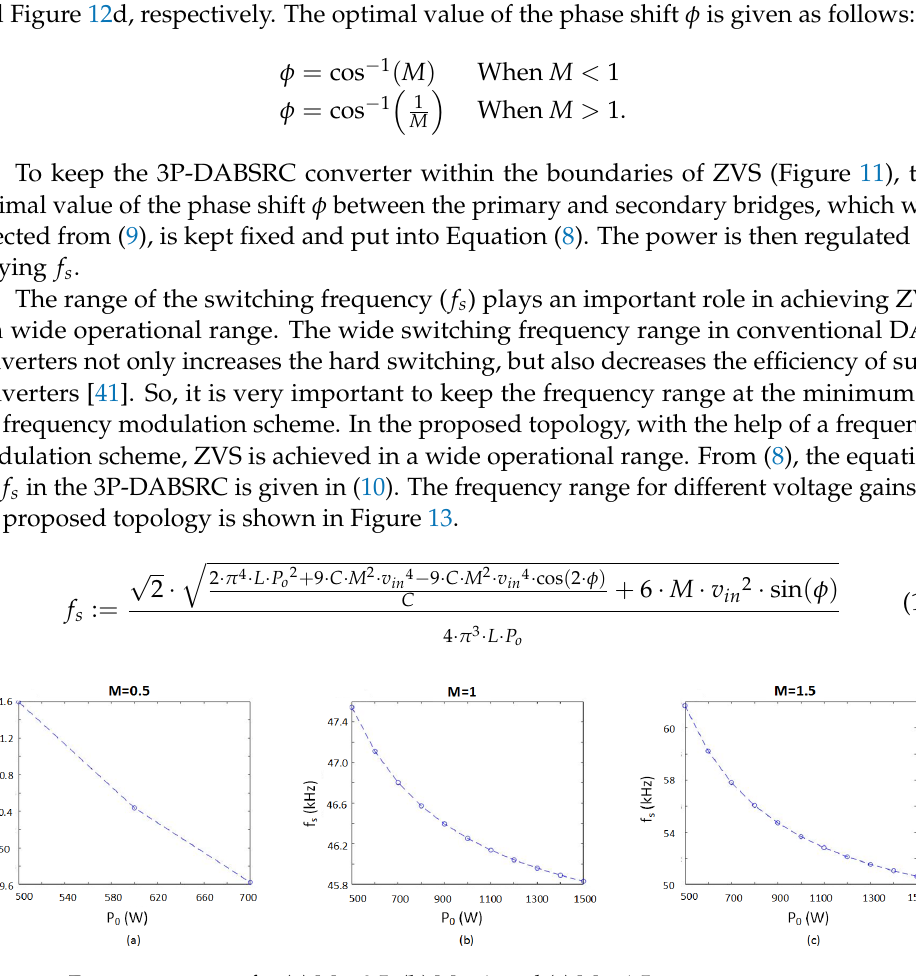
Figure 13. Frequency ranges for ( a ) M = 0.5, ( b ) M = 1, and ( c ) M =